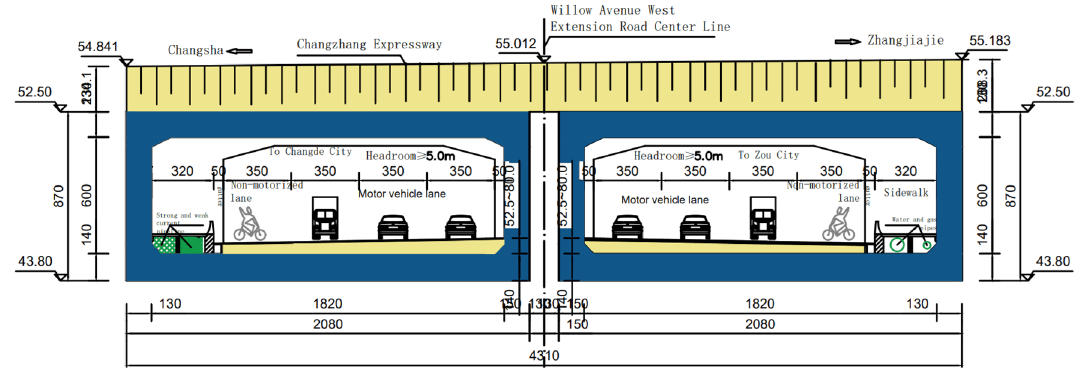
Figure 3. Schematic diagram of the rectangular pipe jacking tunnel of the west extension line of LiuYe Avenue.